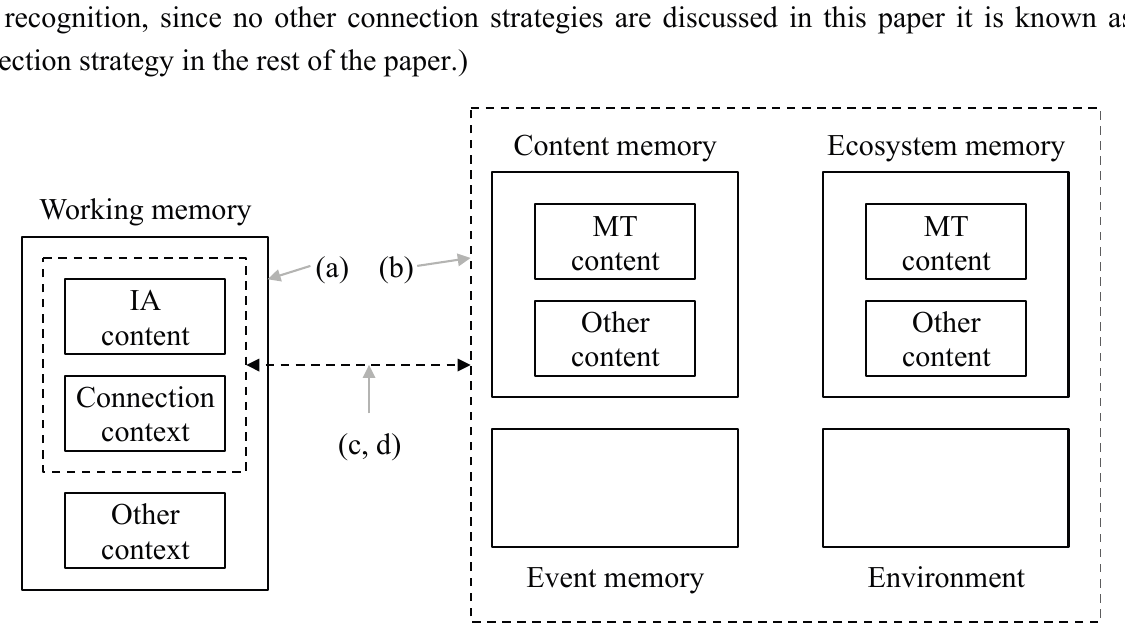
Figure 1. Recognition connection